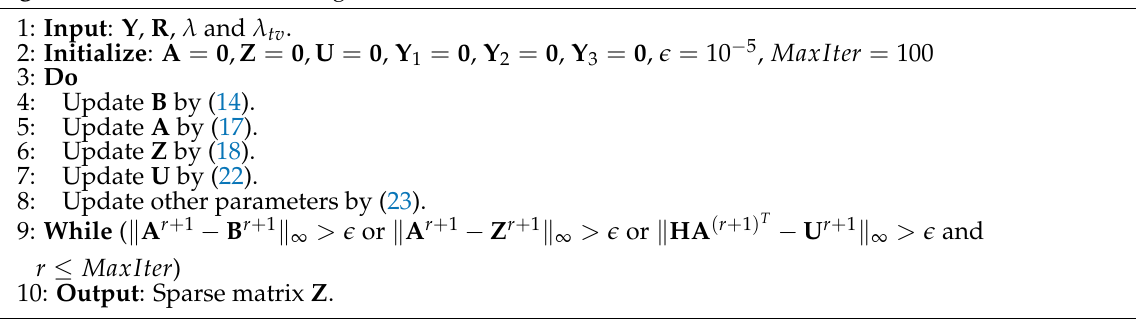
Algorithm 2 ADMM for solving the Sketch-SSC-TV